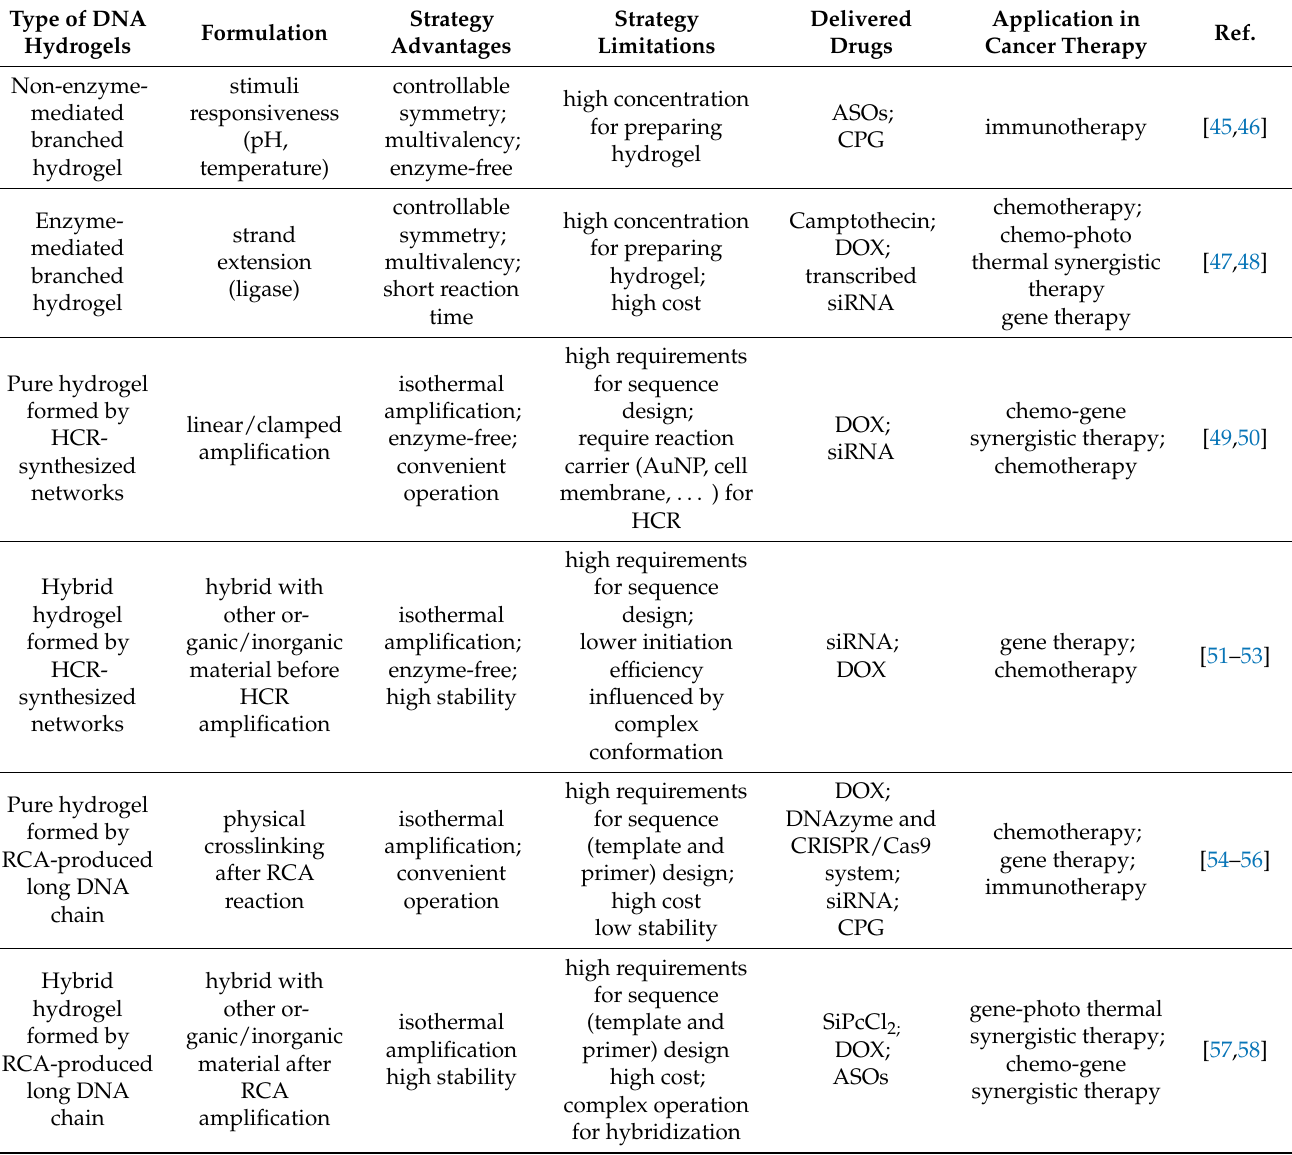
Table 1. The summary of DNA hydrogels formed via branched DNA modules, hybrid chain reaction (HCR)-synthesized DNA networks and rolling circle amplification (RCA)-produced DNA chains, respectively, and their application of drug delivery for cancer